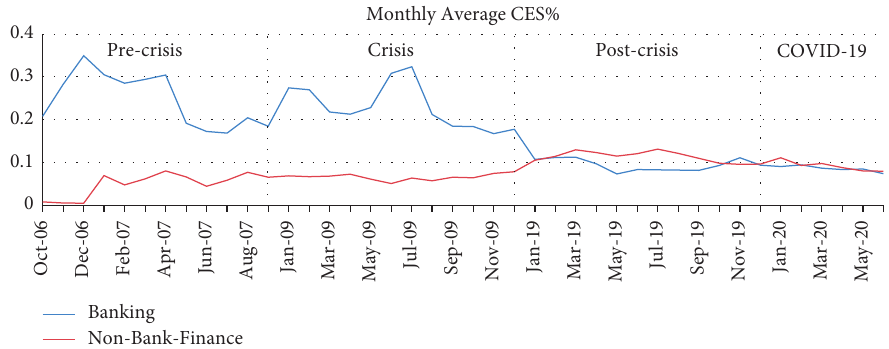
Figure 8: CES of the banking and nonbank finance sectors in four periods (%).